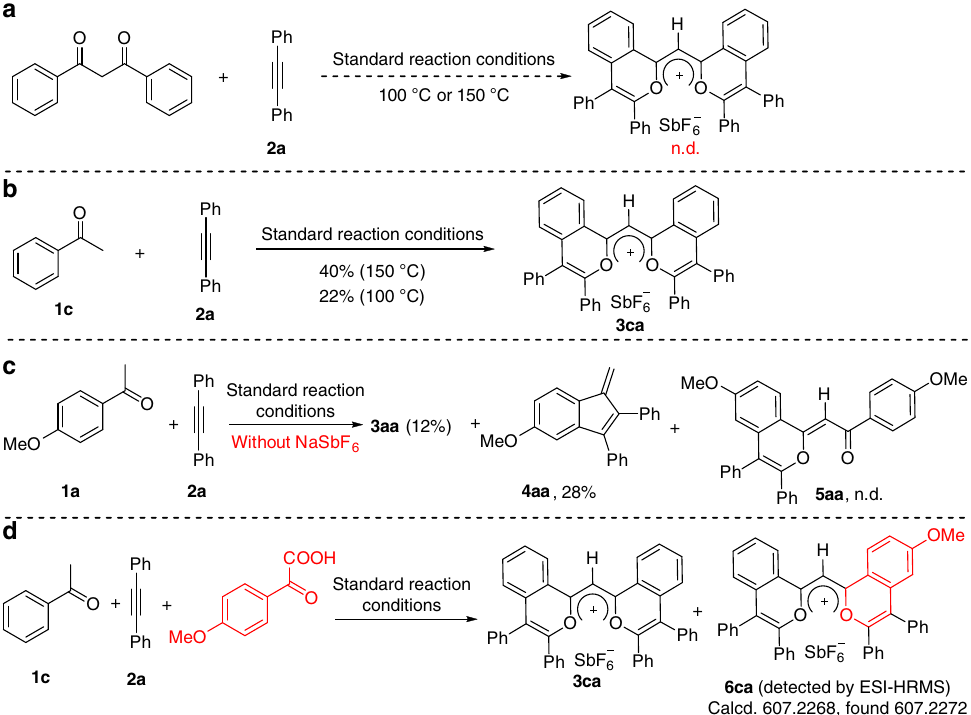
Fig. 5 Control experiments for the reaction mechanism. a The reaction of 1,3-diphenylpropane-1,3-dione with 2a was performed under standard reaction conditions. b The reaction of 1c with 2a was performed under the standard reaction conditions at 100 or 150 °C. c The reaction of 1a with 2a was performed without the addition of the extra anion source NaSbF 6 . d The reaction of 1c , 2a , and 4-methoxybenzoyl formic acid was performed under the standard reaction conditions.